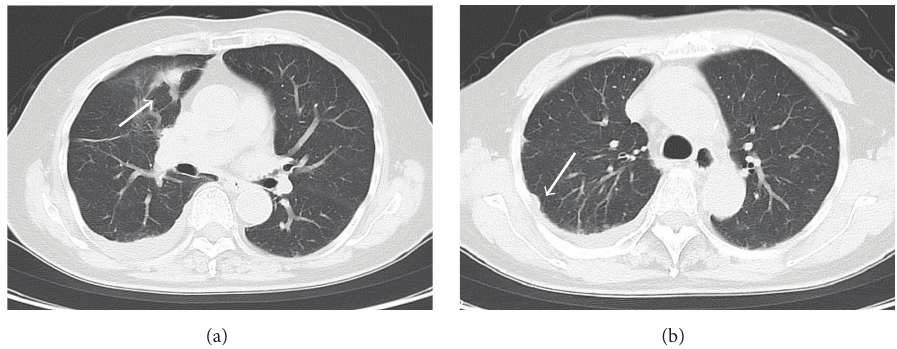
Figure 3: CT images showed nodular lesions in the right lung (a, b → ).